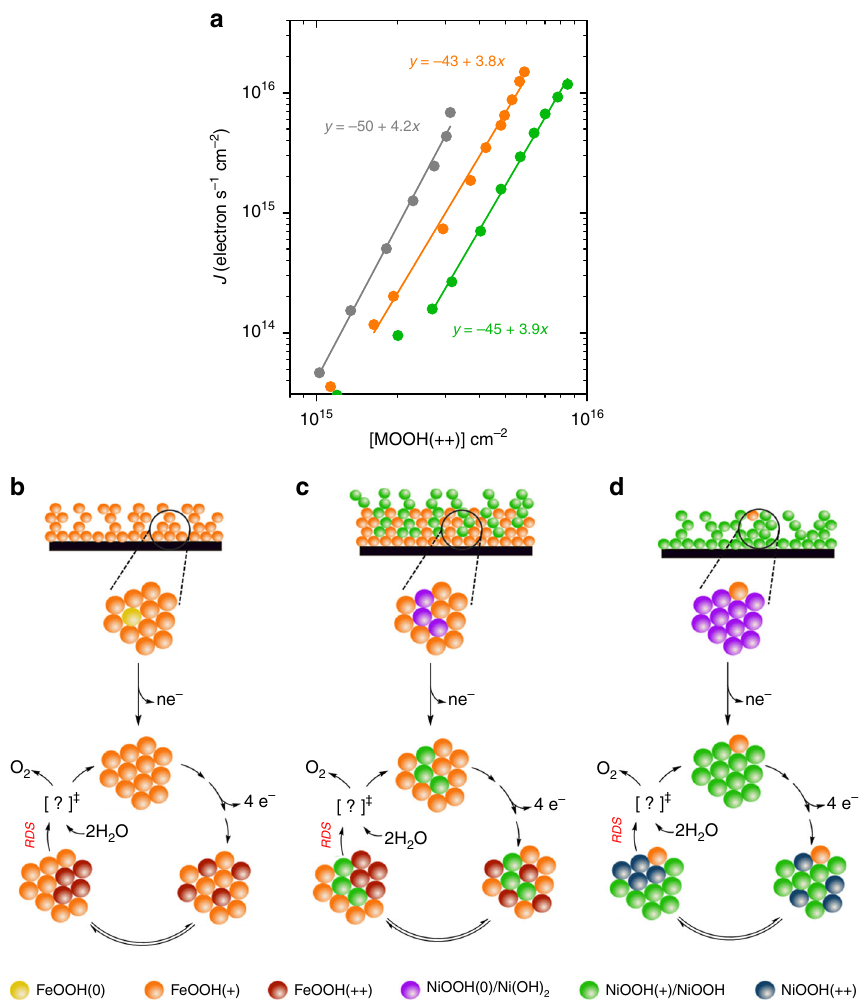
Fig. 5 Mechanistic inights on the WO mechanism. a Rate law plots of the water oxidation current density versus the concentration of MOOH( ++ ) states for FeOOH (orange), Ni(Fe)OOH and FeOOHNiOOH (green). b – d Simple schematic representations of the water oxidation process based on the experimental observations herein for ( b ) FeOOH, ( c ) Ni(Fe)OOH and ( d ) FeOOHNiOOH. Further details of shorter-lived intermediates are beyond the focus of this study. Colour code: FeOOH(0) corresponding to reduced defect states in FeOOH (yellow spheres); FeOOH( + ) (orange spheres); FeOOH( ++ ) (red spheres); NiOOH(0) corresponding to Ni(OH) 2 (purple spheres); NiOOH( + ) corresponding to NiOOH (green spheres); NiOOH( ++ ) (blue